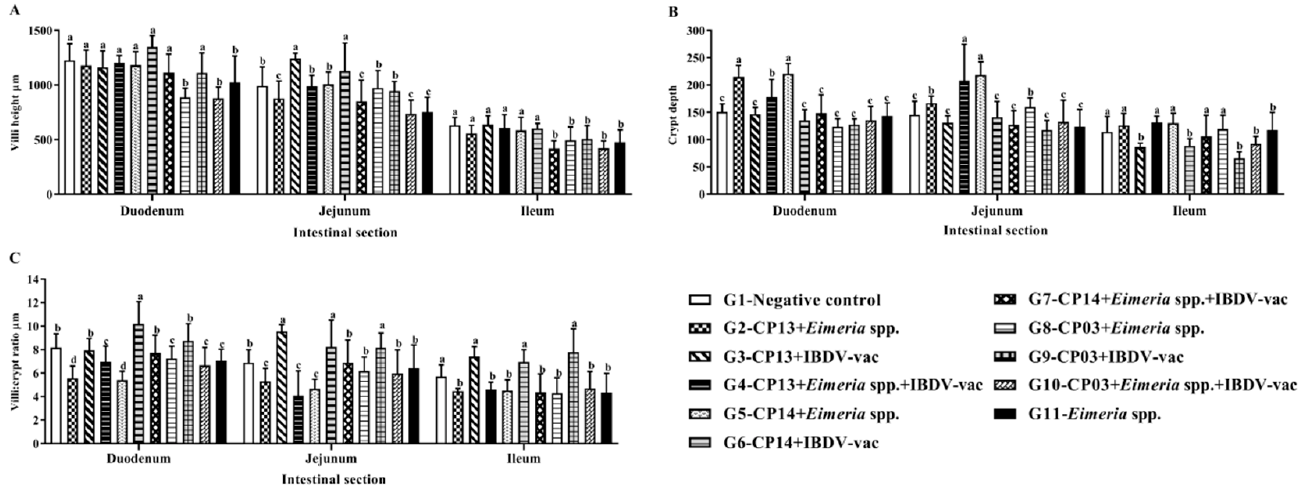
Figure 2. Mean villus height, crypt depth, and villus/crypt ratio of the different groups. a,b,c Different letters in the column indicate a significant difference ( p ≤ 0.05) between groups. Scott–Knott test at 5% significance